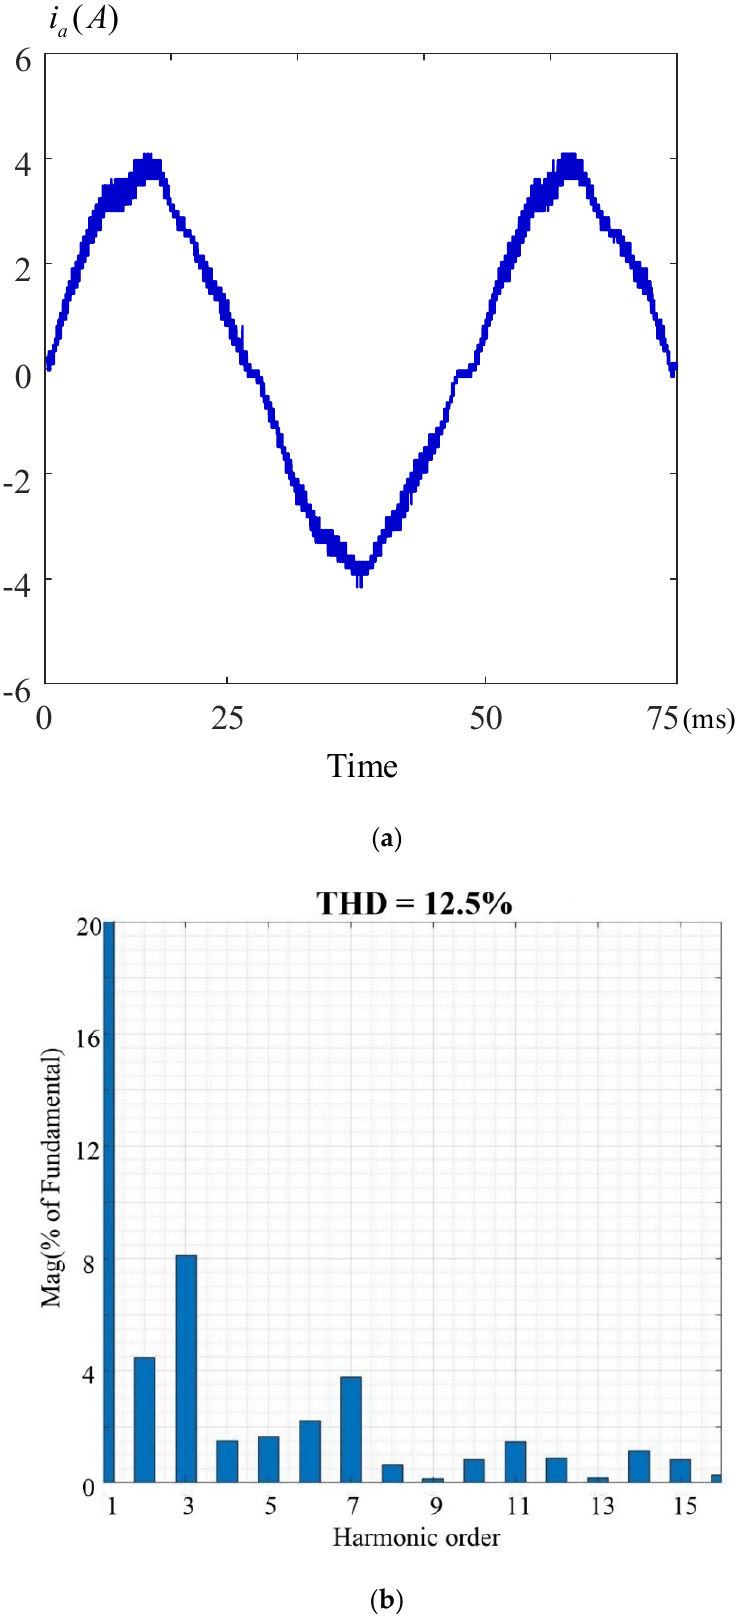
Figure 16. Measured a -phase current using PI controller. ( a ) waveform, ( b ) harmonics.